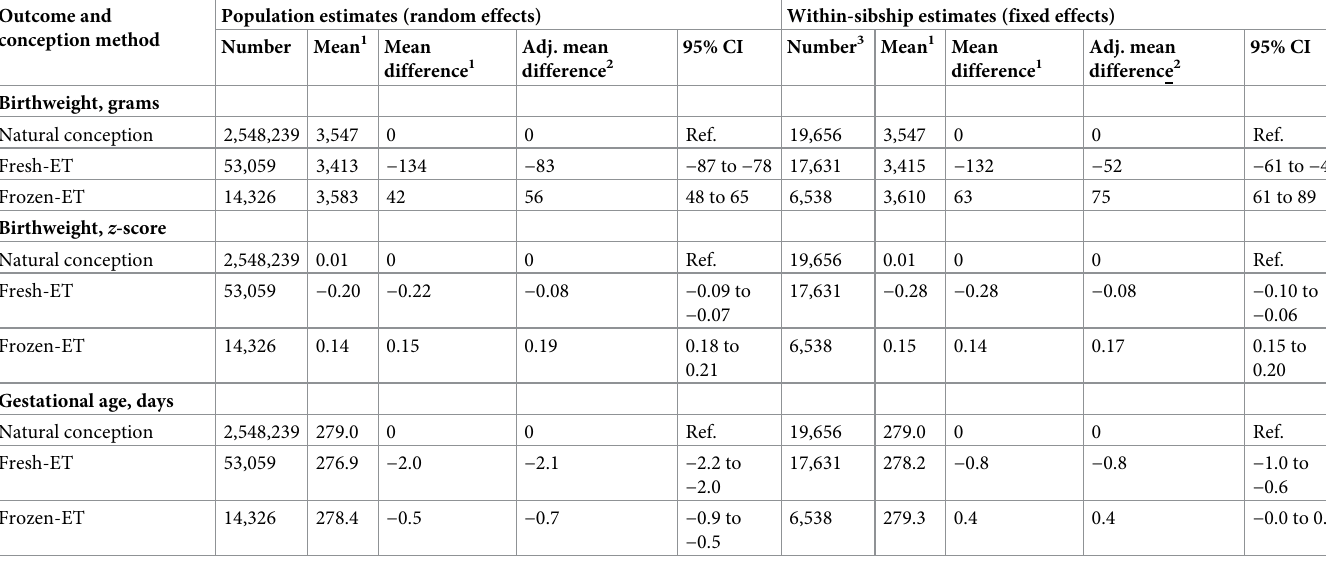
Table 3. Birthweight and gestational age by conception method: Population estimates and within-sibship estimates in main sample 2 (minimizing confounding). Outcome and conception